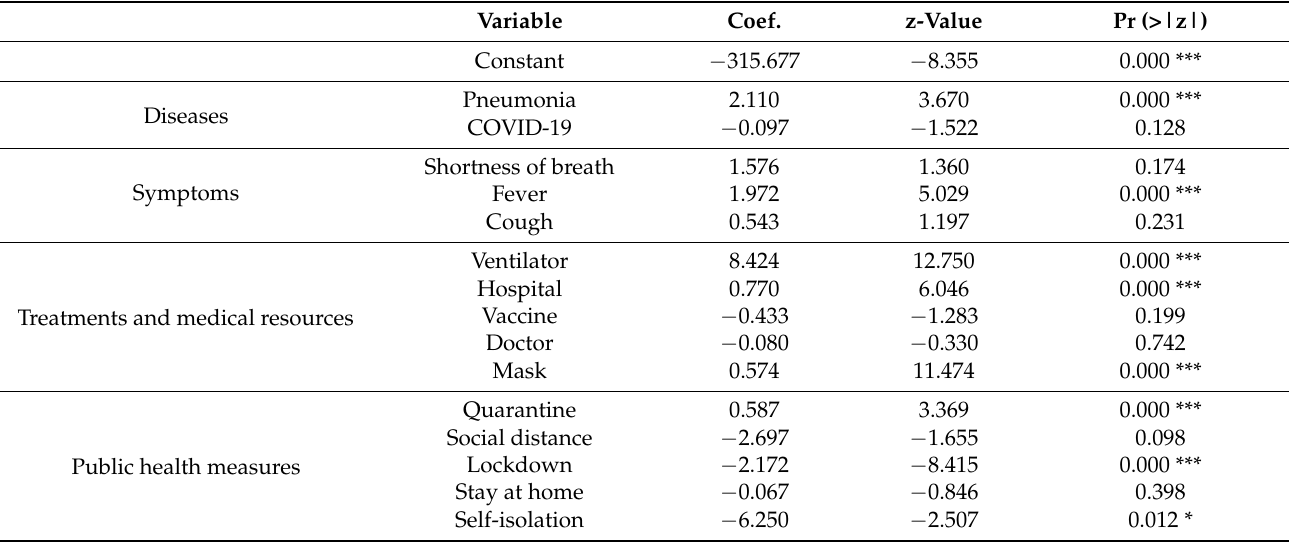
Table 4. Random effect results of the full sample of Model